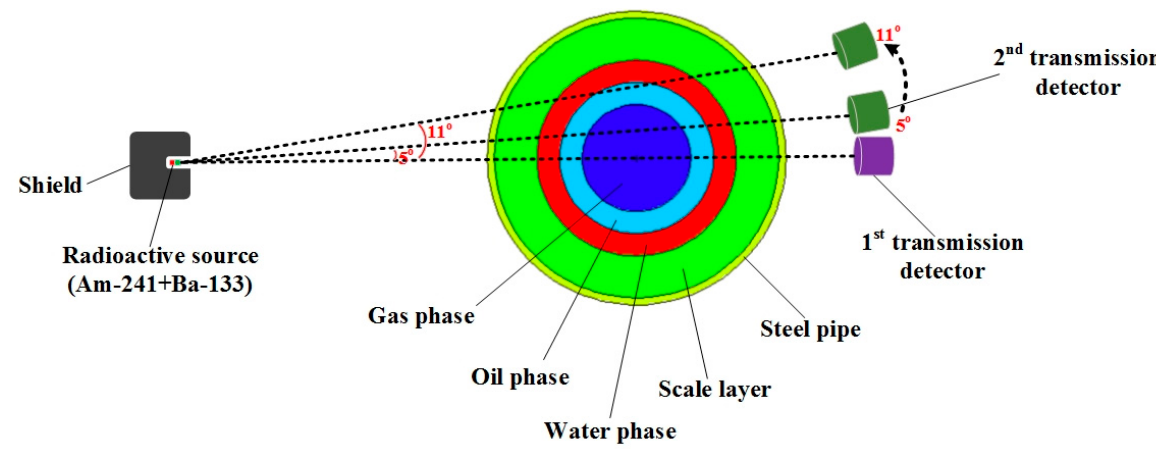
Figure 2. Investigation of optimum position for the second detector in the proposed system.